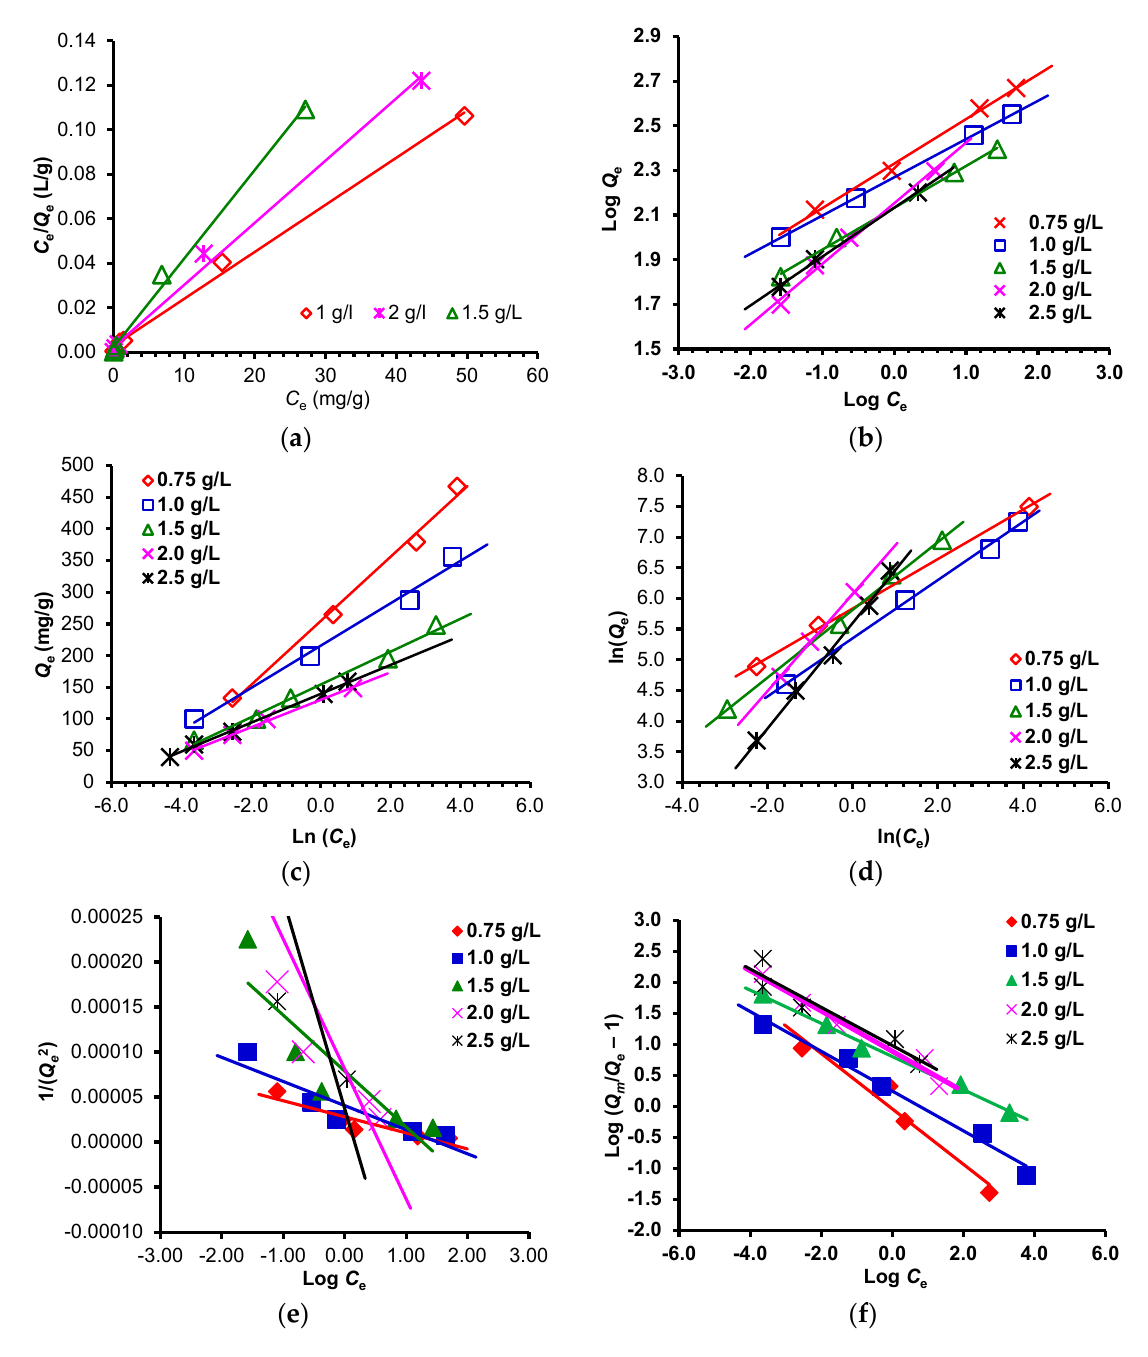
Figure 10. ( a ) Linearized Langmuir adsorption isotherm, ( b ) linearized Freundlich adsorption isotherm, ( c ) Tempkin adsorption isotherm, ( d ) Halsey adsorption isotherm, ( e ) Harkins–Jura isotherm, ( f ) generalized isotherm for AO7 dye of initial concentration (100–400 mg/L) on pea pods AC/ZnCl 2– 800 °C under CO 2 doses at 25 ± 2 °C.